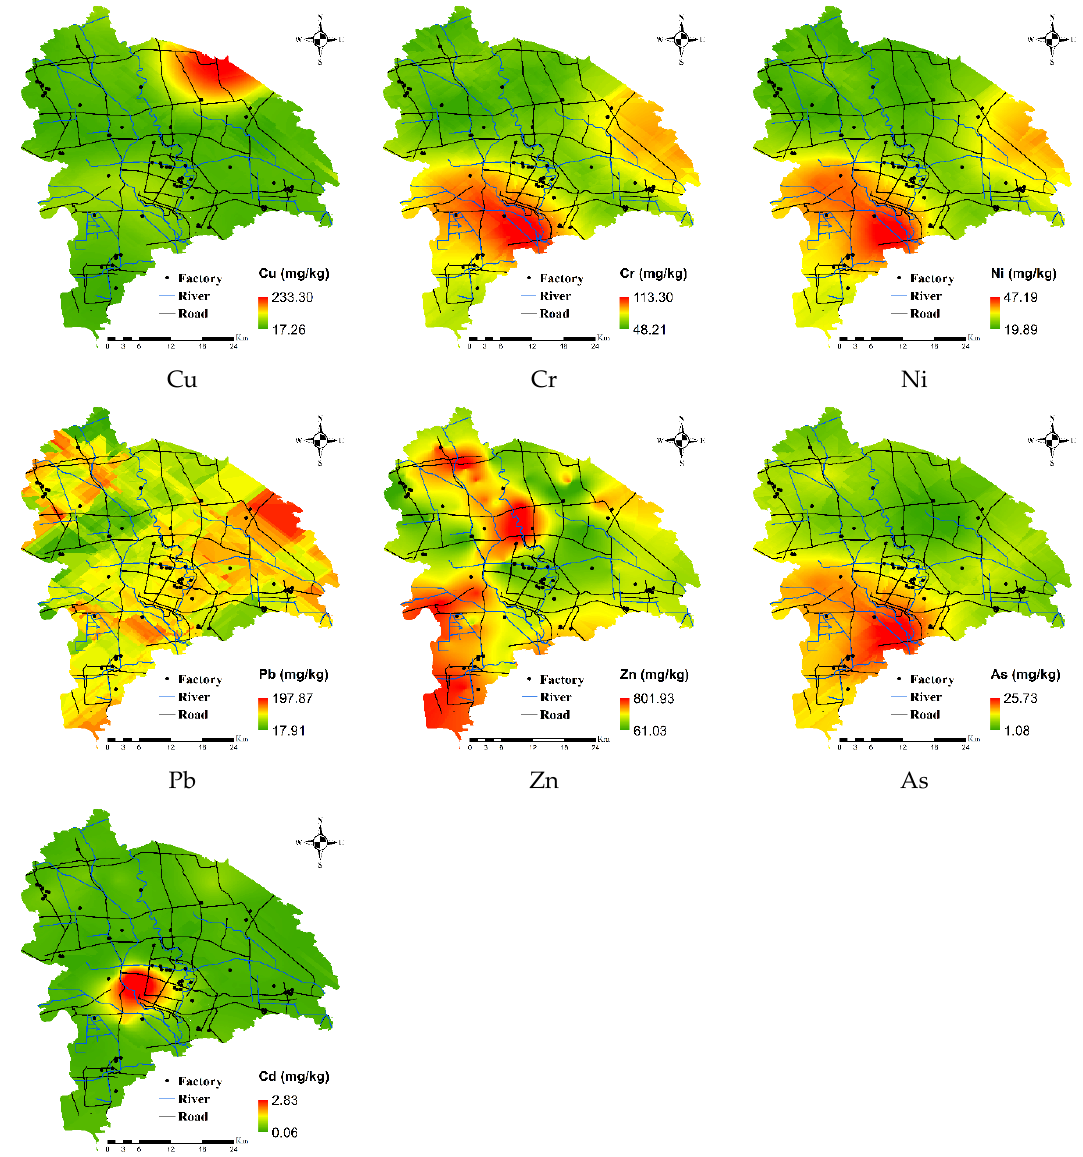
Figure 6. Spatial distribution of HMs in the study area.